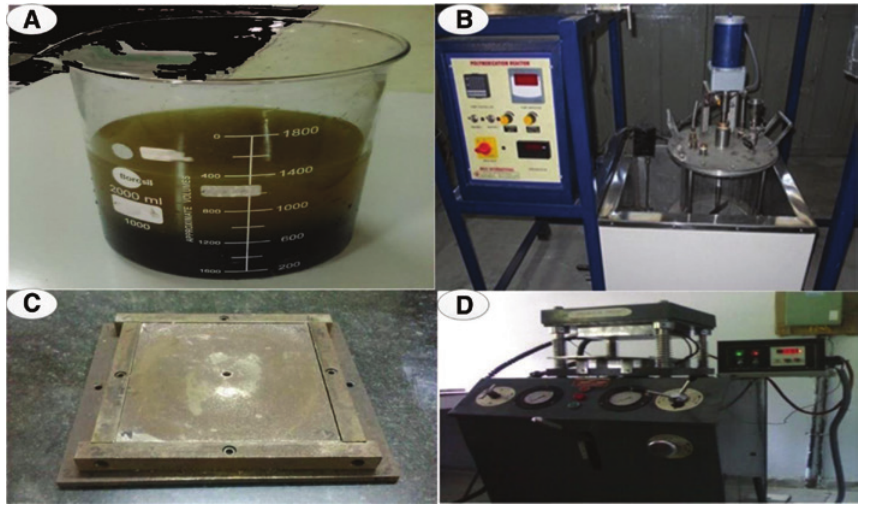
Figure 1: Diagrams of the experimental